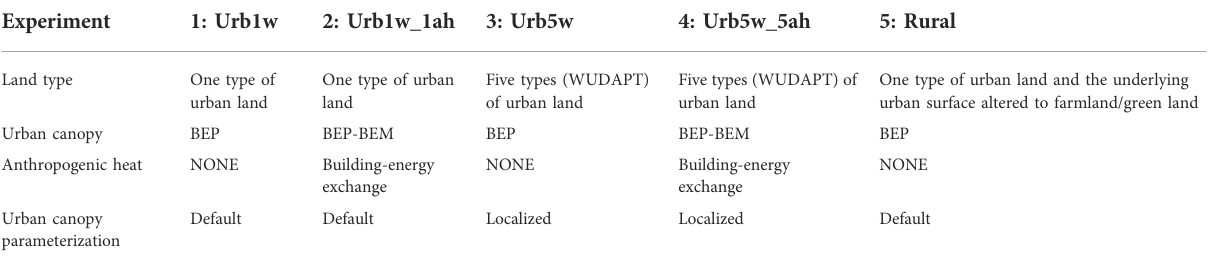
TABLE 2 The fi ve groups of experiments and their urban canopy and anthropogenic heat settings.